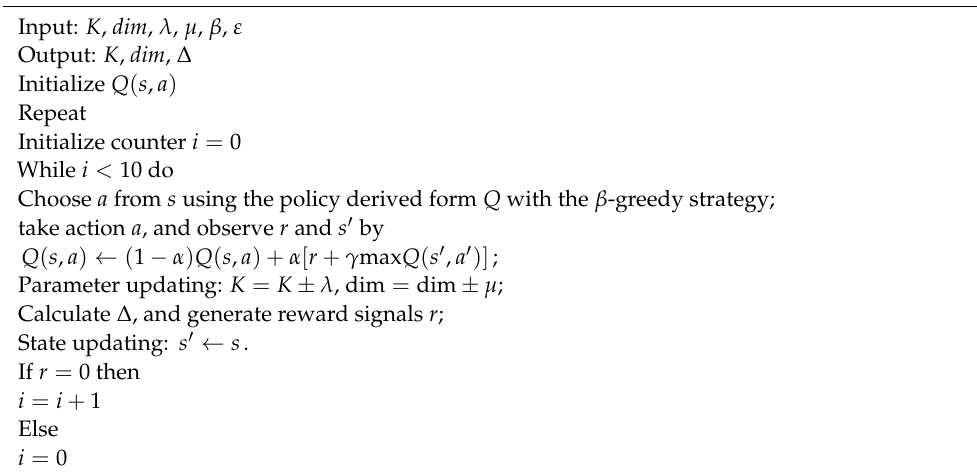
Algorithm 1: The Q-learning applied in our